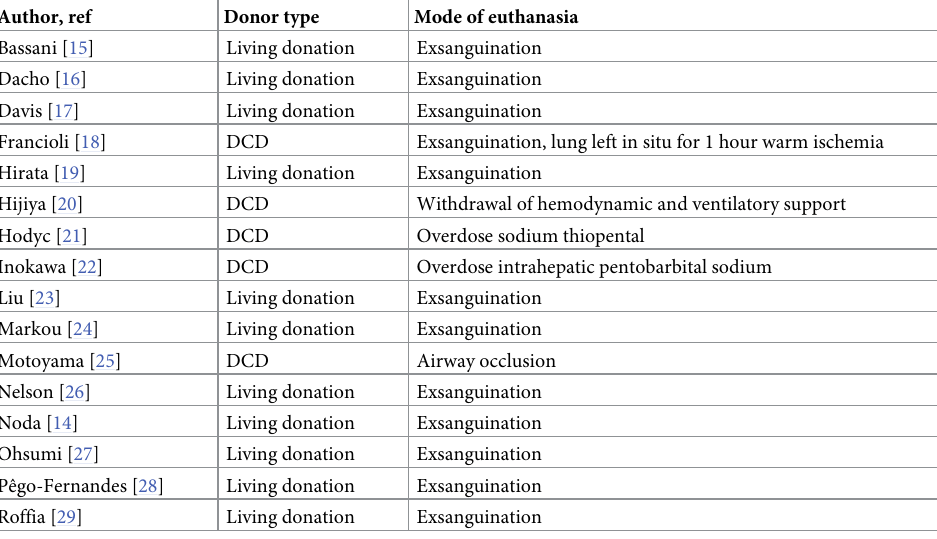
Table 3. Donor type characteristics of reported rat ex vivo lung perfusion